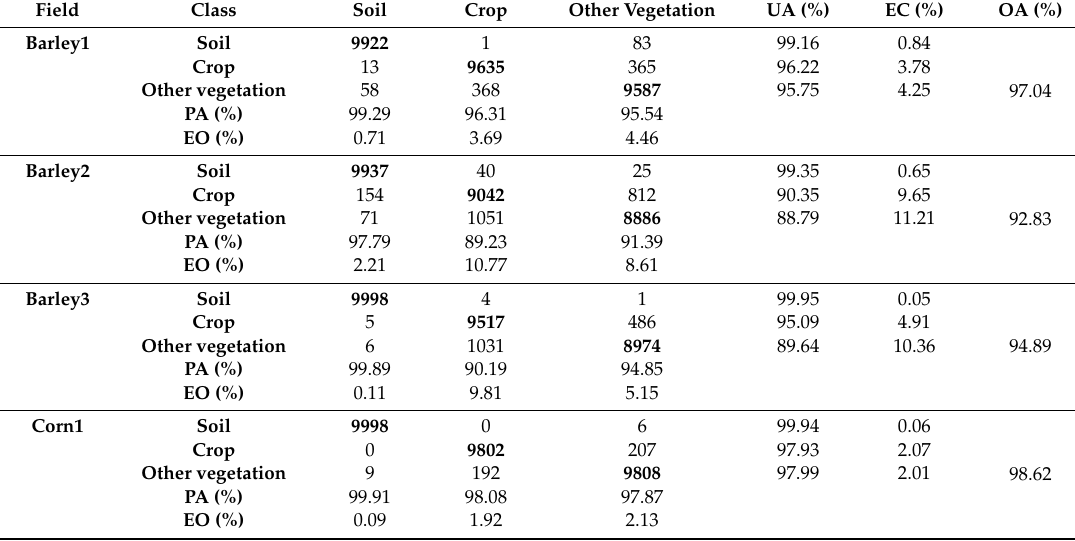
Table 10. Confusion matrices and associated class user’s accuracies, producer’s accuracies, overall accuracies, errors of omission and errors of commission obtained by applying the PBIA random forest classifier to the blue, green, red, red-edge, near-infrared reflectance and blue-red simple ratio images. The bold diagonal number elements are the correctly classified pixels for each